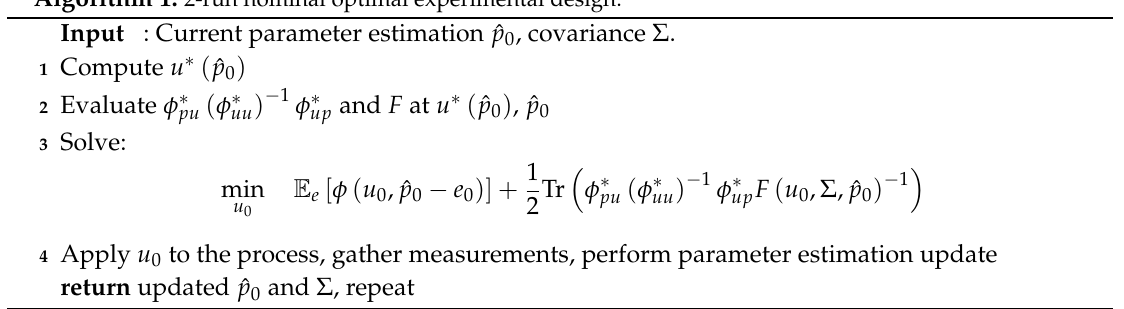
Algorithm 1: 2-run nominal optimal experimental